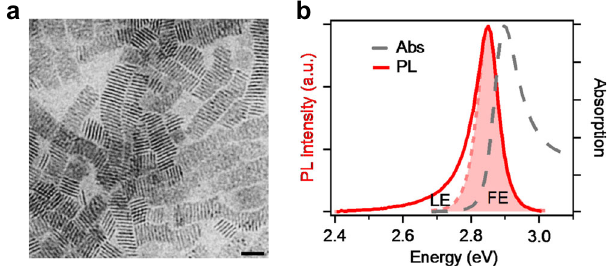
Fig. 1 Characterization of 2L CsPbBr 3 NPs. a TEM image of 2L CsPbBr 3 NPs. Scale bar is 20 nm. b Absorption and PL spectra of 2L CsPbBr3 NPs in toluene solution. The red shaded area is vogit fi tting of main peak, which is denoted as FE and the rest as